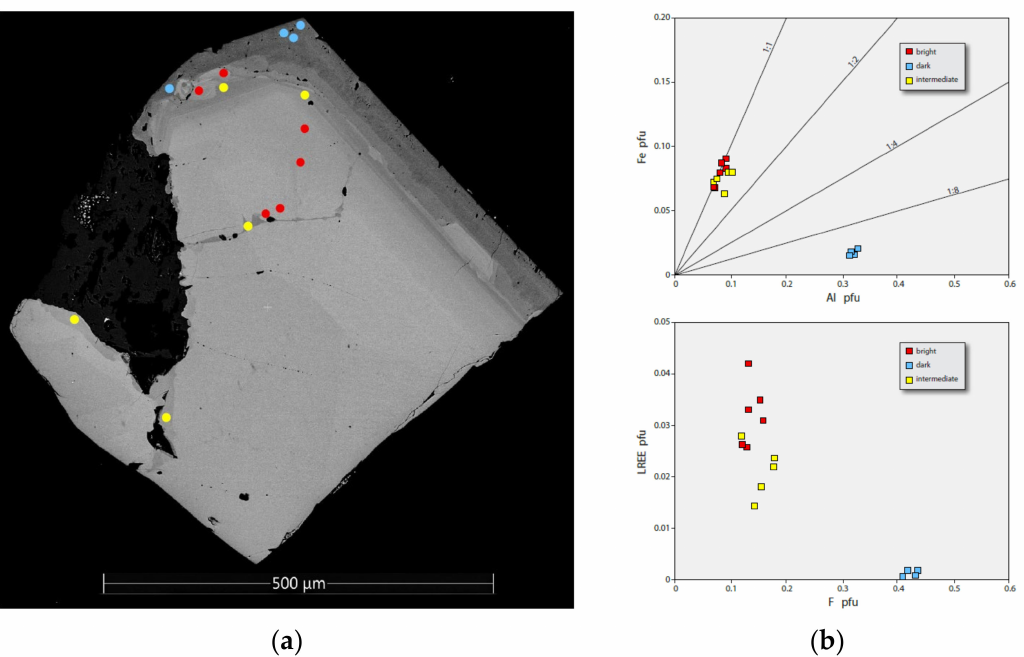
Figure 27. BSE image of titanite grain from a miarolitic cavity in an aplite west of Milford, Utah ( a ). These miarolitic cavities also contain K-feldspar, albite, epidote, smoky quartz, and fluorite crystals. This titanite grain was broken out of the cavity but preserves (along top of photo) the euhedral edge that was growing into the cavity. The graphs at the right show that the dark gray rim has high Al and F as well as low Fe and LREE (La, Ce, Nd, Sm) concentrations ( b ).